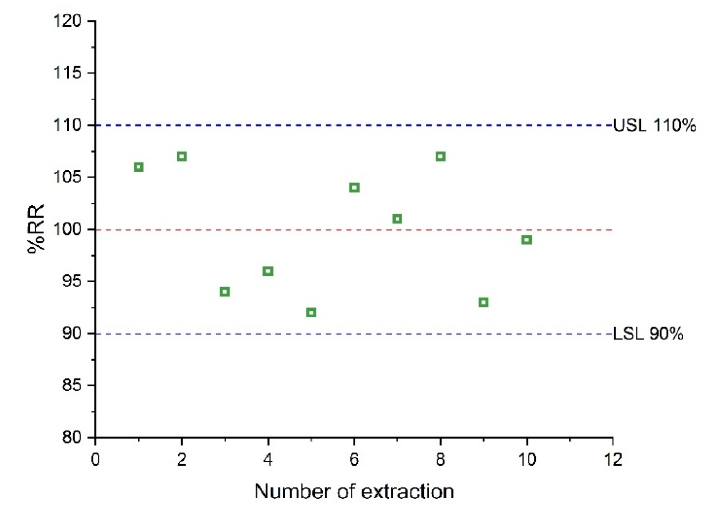
Figure 6. Reusability of CW 20M CPME membrane.